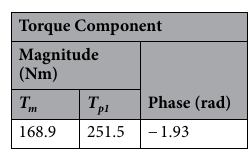
Table 2. Employed input torque profiles from the engine dynamometer